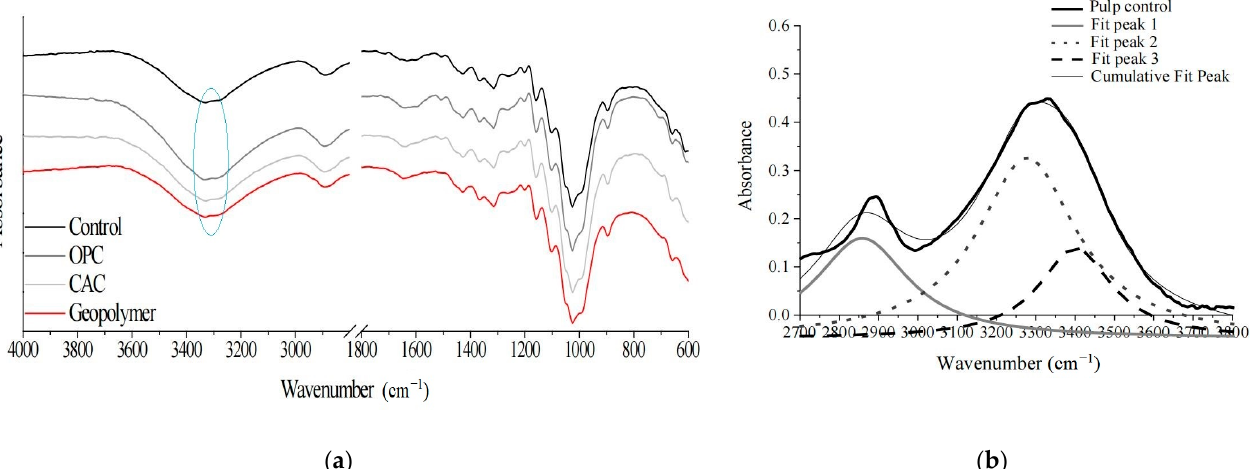
Figure 7. Pulp FTIR analysis of OPC, CAC, and geopolymer. ( a ) FTIR spectra of pulp in the control condition and after 28 days of immersion in the OPC, CAC, and geopolymer pastes; ( b ) Deconvoluted FTIR spectra of pulp control condition [72].